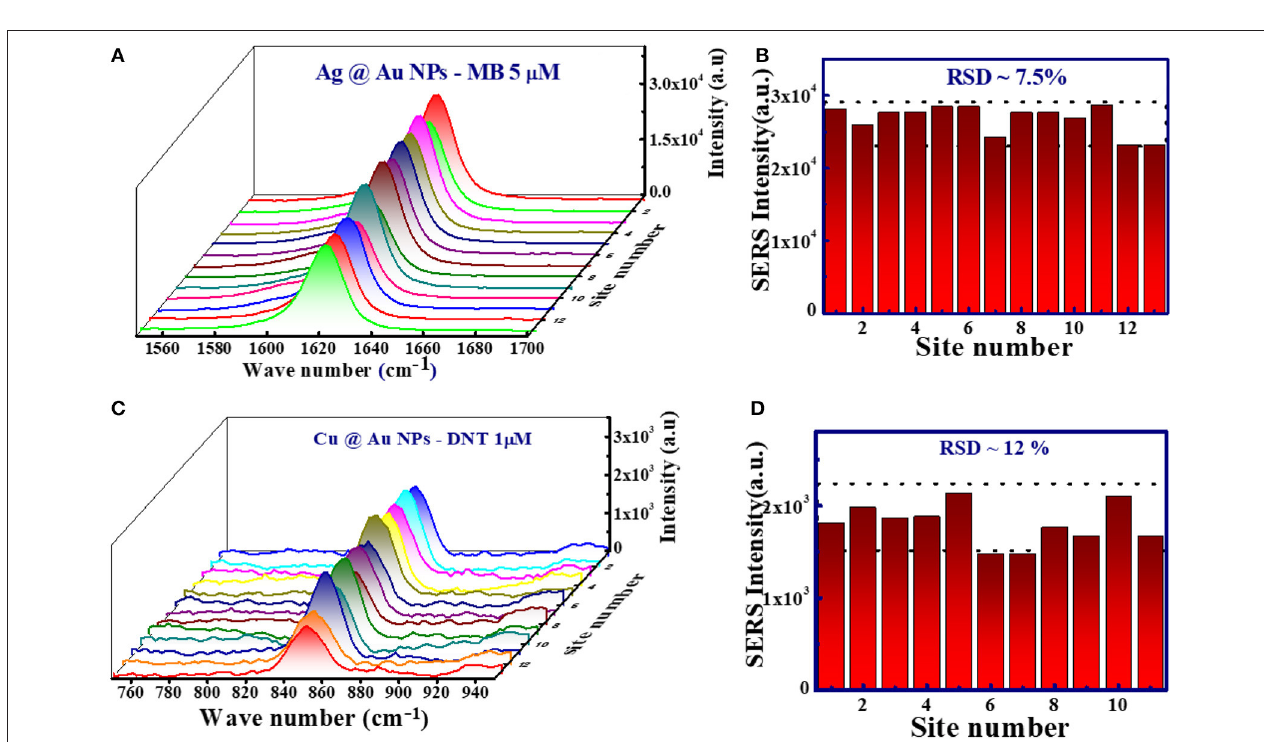
FIGURE 8 | (A) SERS spectra of MB using Ag@Au NPs film recorded multiple times at different sites. (B) SERS intensity of 1622 cm − 1 peak collected from Ag@Au NPs film. (C) SERS spectra of DNT using Cu@Au NPs film. (D) SERS intensity of 849 cm − 1 peak collected from Cu@Au NP film at different sites with an excitation wavelength 785nm and an integration time of ∼